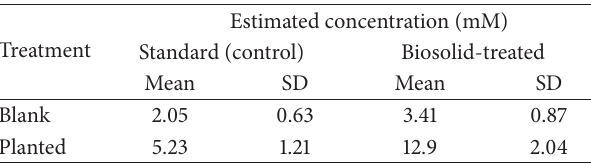
Table 4: Estimated solution concentrations (16-week average) of organic acid mixtures in root exudates of corn †